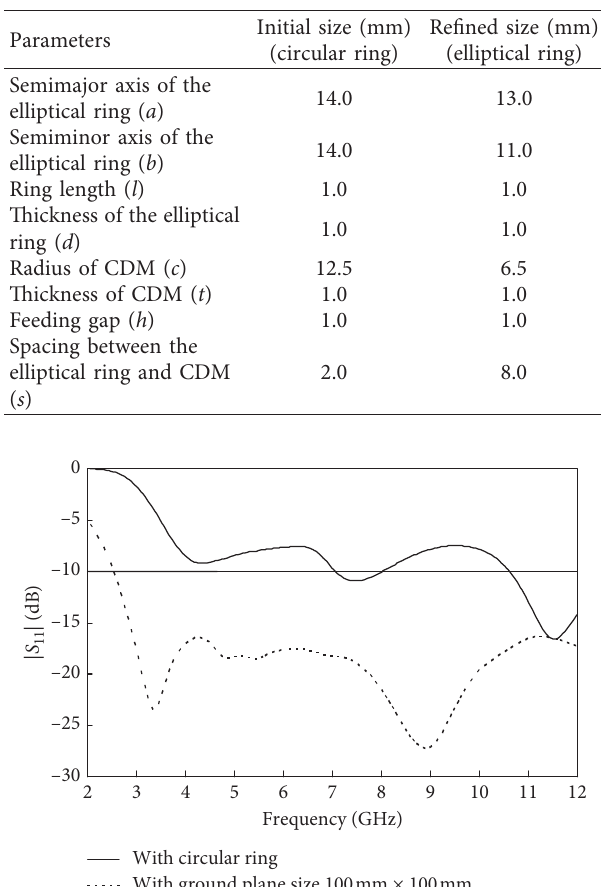
Figure 1: Schematic of the elliptical ring antenna excited by the circular disc monopole. Table 1: Parameters of CDM-excited circular and elliptical ring antennas.